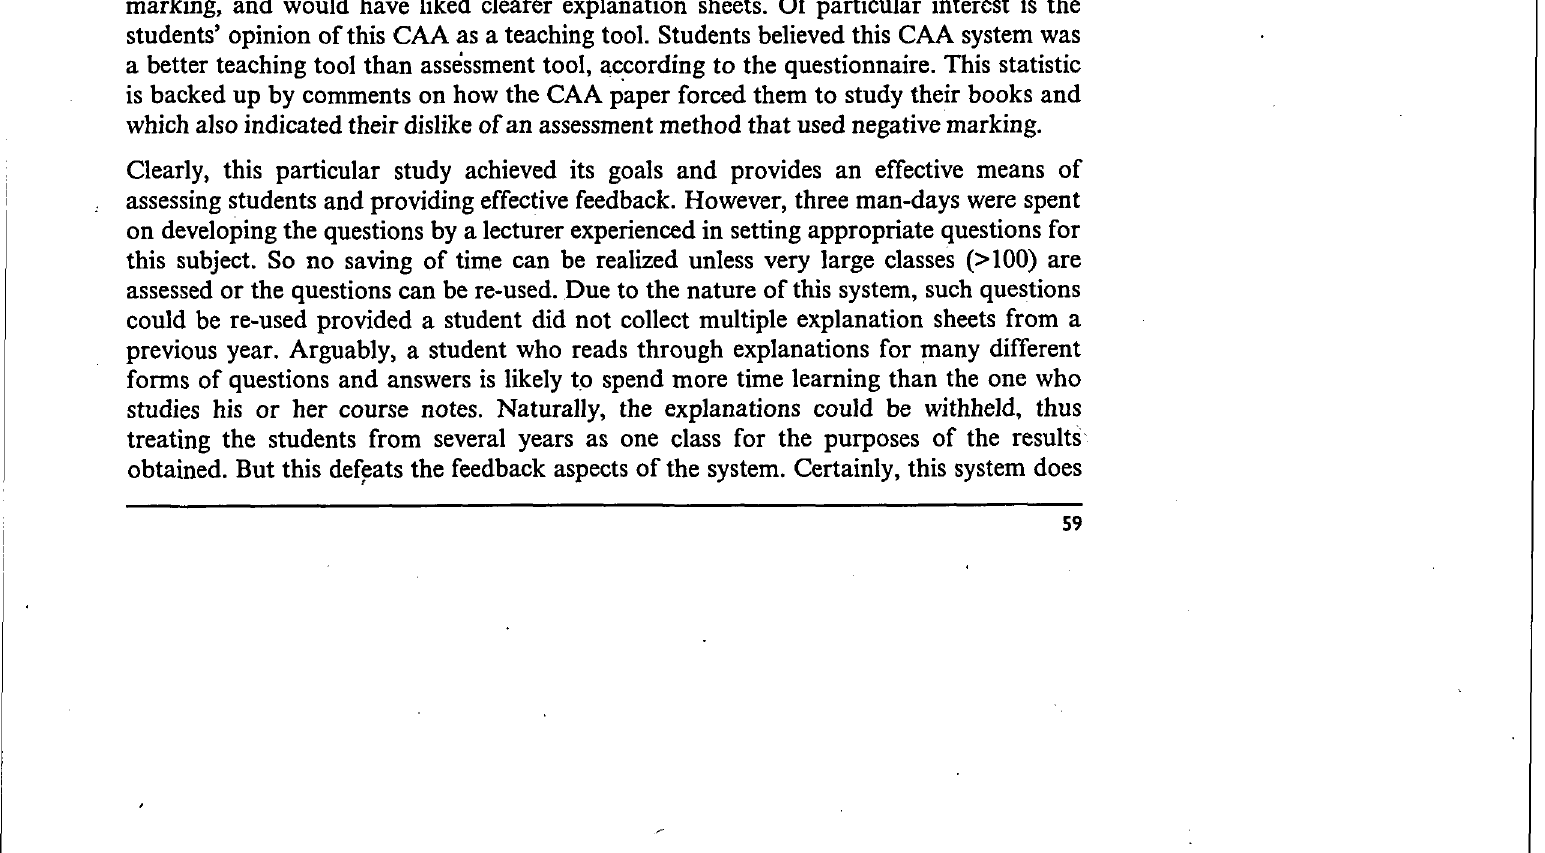
Figure / 2: Bar chart showing the percentage results for the